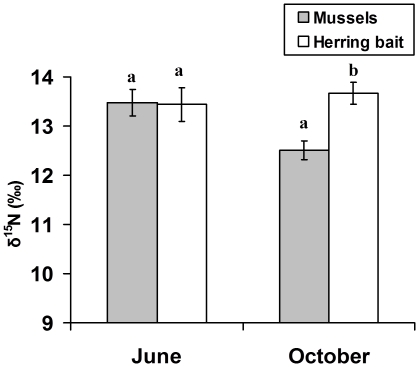
The effects of herring bait on lobster N SIR values.N SIR values of lobsters reared on herring bait (n = 5) vs. mussels (n = 6) in the laboratory at the Darling Marine Center (error bars  = +1 SE). N SIR values were similar at the start (June) of the experiment, but lobsters that consumed mussels were significantly lower at the end (October) of the experiment. Letters denote the results of Ryan's Q post hoc tests–bars with different letters were significantly different at p<0.05.